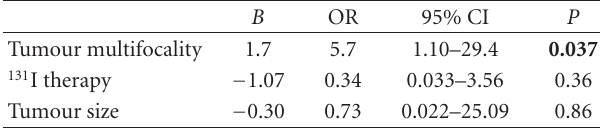
Table 4: Cox regression analysis of predictive